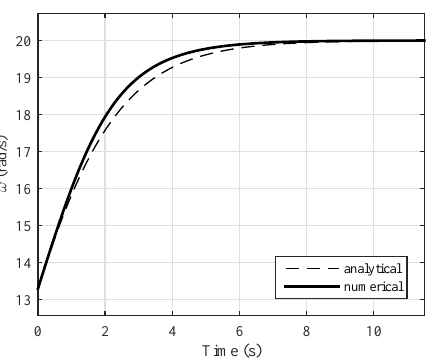
Figure 10. Runaway development of a 12-kW vertical axis wind